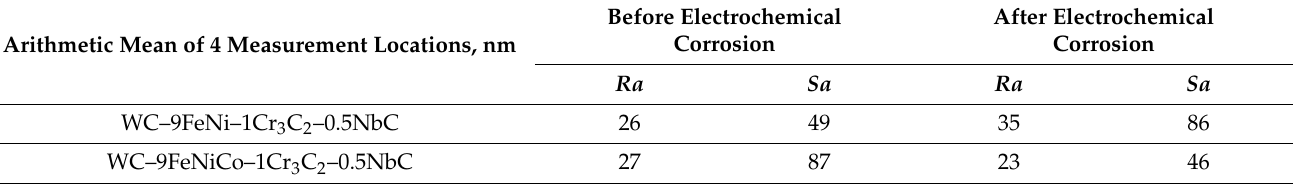
Table 7. Re-characterization results of the sample surface changes after corrosion using an optical measurement sensor.